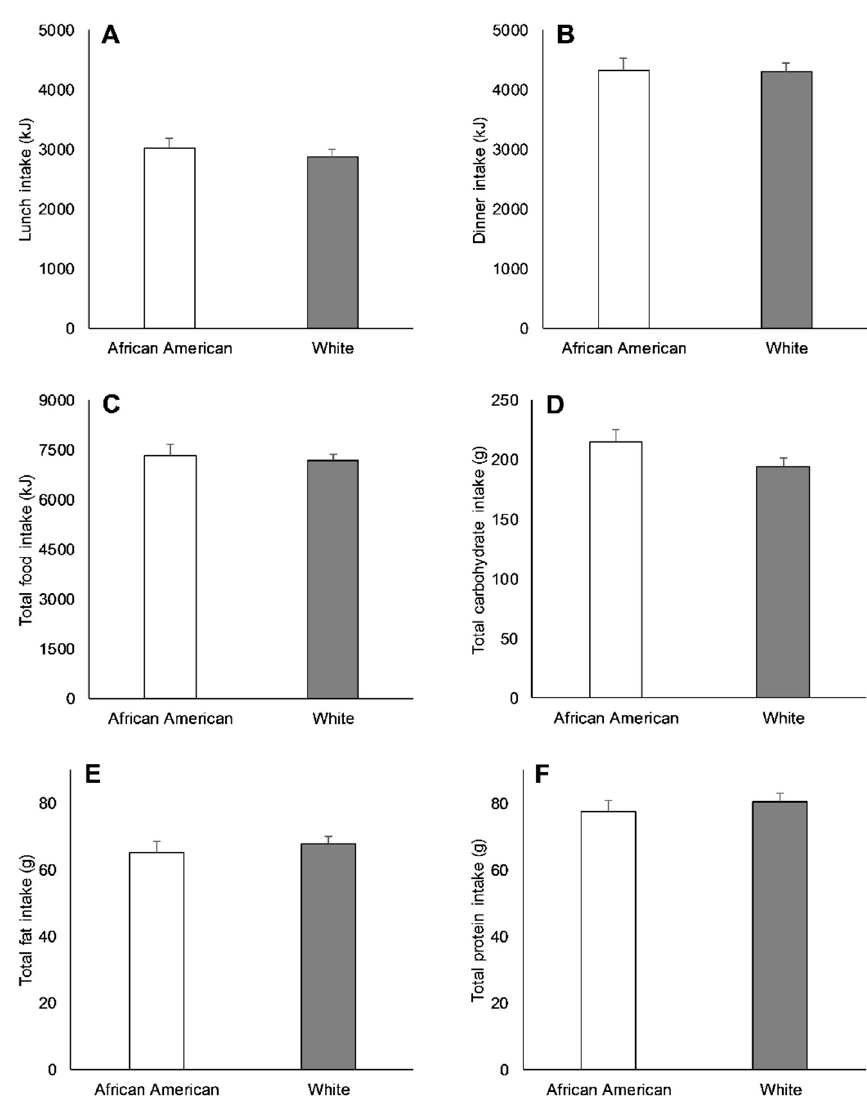
Figure 4. Lunch energy intake ( A ), dinner energy intake ( B ), total energy intake ( C ), total carbohydrate intake ( D ), total protein intake ( E ), and total fat intake ( F ) between African Americans (AAs) and Whites during the baseline visit. No significant differences between races were observed ( p ≥ 0.05). Values are means ± SEM.